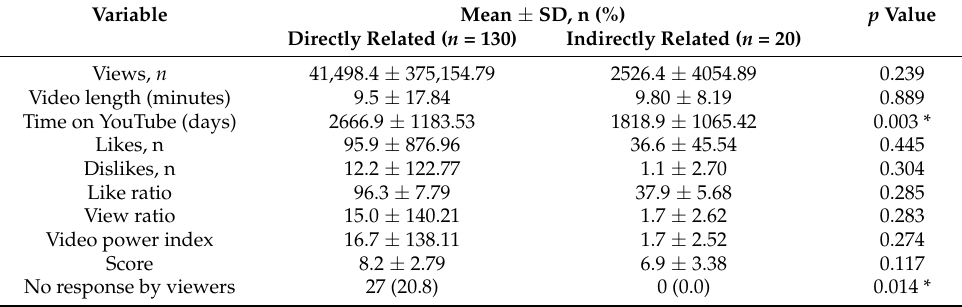
Table 3. Content comparison of the videos.